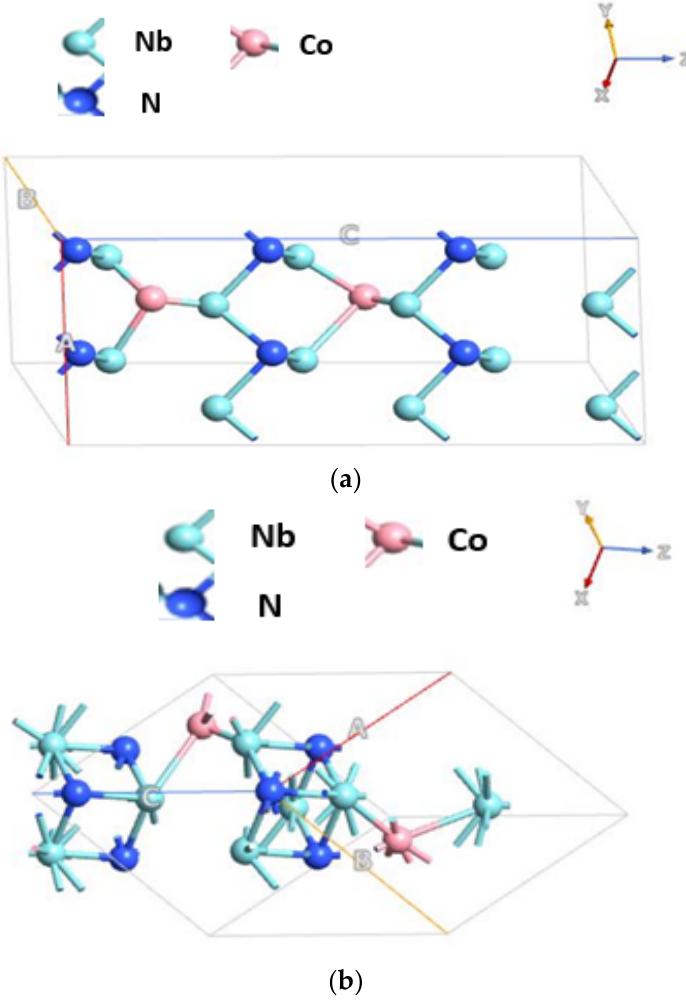
Figure 2. Chemical structures of doped niobium nitride: ( a ) Nb 2 N-2Co; ( b ) Nb 4 N 3 -2Co. Quantum capacitance of electrodes was calculated using the computed density of states (DOSs). If φ is the operating voltage and Q is the surface charge on niobium nitride, then, from density of state DOS (E), we can find quantum capacitance using Equations (2)–(4) [59,60]: